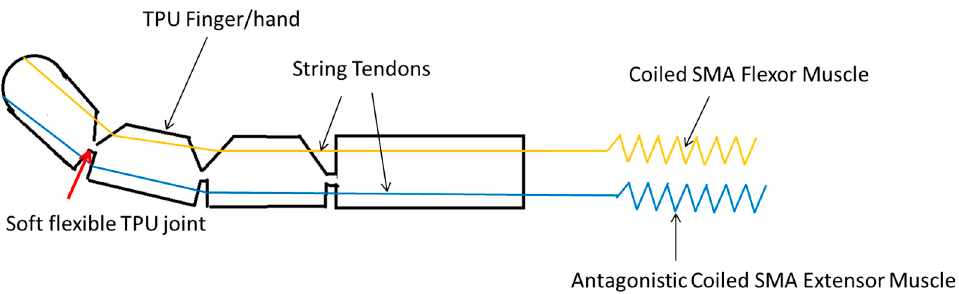
Figure 2. Schematic diagram of the robotic hand actuated by coiled SMA.